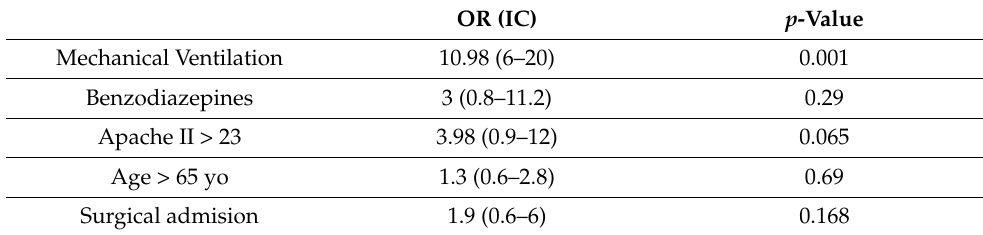
Figure 1. ICU LOS considering worse diagnosis in the first 72 h. Legend: The boxplot represents the median (IQR) of survivors and non-survivors according to mental status: normal, SSD and delirium or coma. The median (IQR) ICU LOS of non-survivors was, respectively, 10 (8–15), 9 (8–15), 14 (9–21) days, with normal vs. SSD p = 0.973, SSD vs. delirium/coma p = 0.014, normal vs. delirium/coma p < 0.001 and the survivors was, respectively, 3 (3–4.5), 5 (3–9), 17 (9–27) days, with normal vs. SSD p < 0.001, SSD vs. delirium/coma, p < 0.001, normal vs. delirium/coma p < 0.001. Four patients with more than 70 days of LOS were excluded. Each circle means: outlier patients and the asterisk means: extremely outlier patient. Table 2. Risk factors to conversion from SSD to